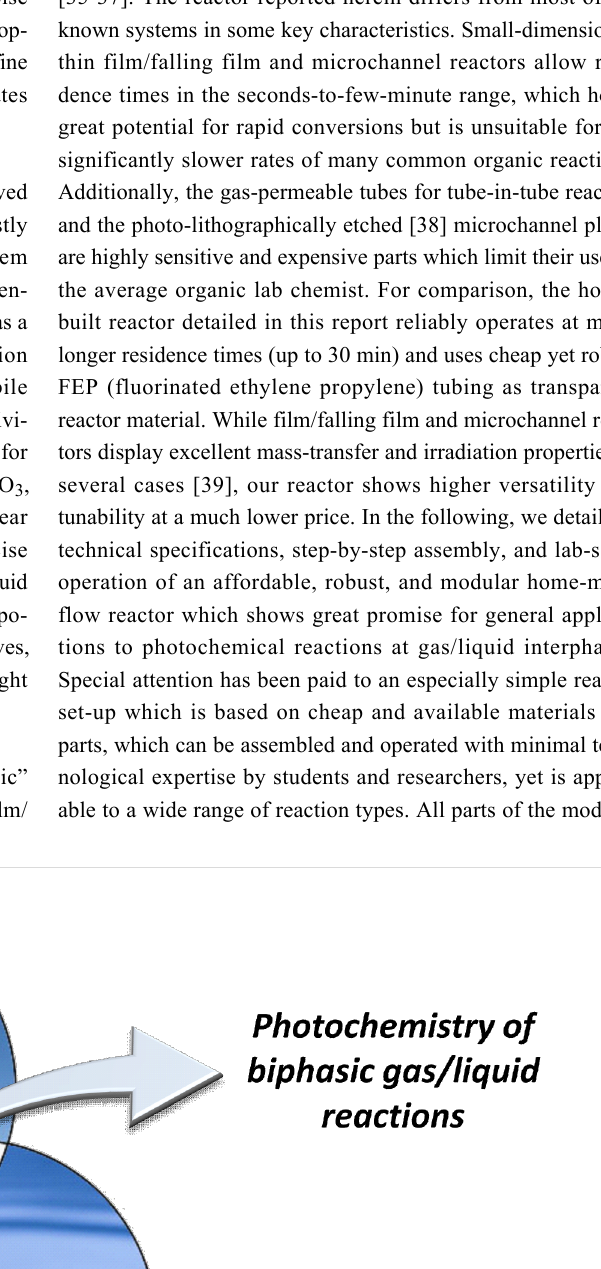
[24,25] for reactions between gaseous and liquid